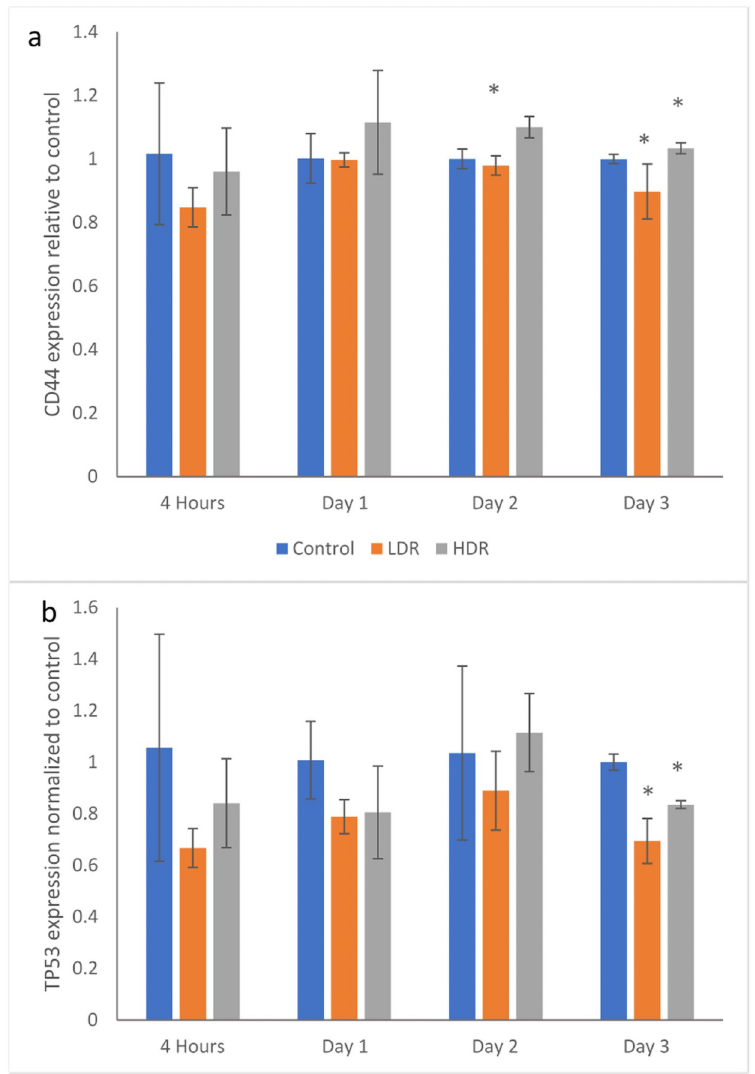
Fig 5. Gene expression for a) CD44 and b) TP53 in 2Gy irradiated ADSCs relative to control condition at each time point. N = 3 independent experiments for each time point and condition and � = p < 0.05 relative to control.